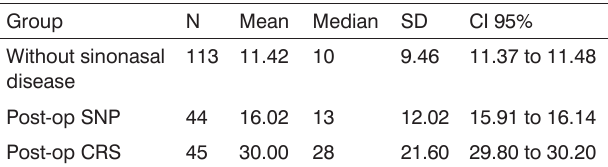
Table 3. Comparison of postoperative scores.